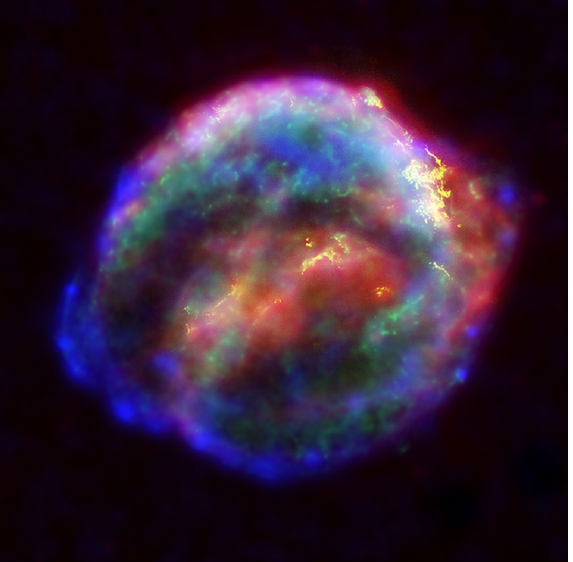
Figure A6. The remnants of Supernova 1604 or Kepler’s Supernova. It was a Type Ia supernova that occurred in our galaxy in the constellation of Ophiuchus. It was observable by the naked eye and was named by Johannes Kepler who described it in: De Stella Nova. Adapted from: